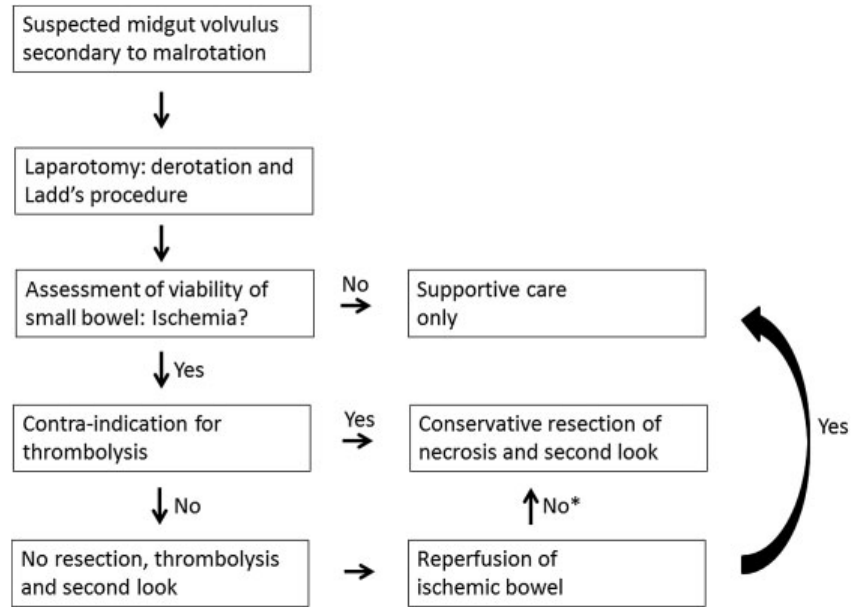
Fig. 3 Flow chart of the clinical course of midgut volvulus in neonates. (cid:1) Consider rethrombolysis after conservative resection of necrotic segments.